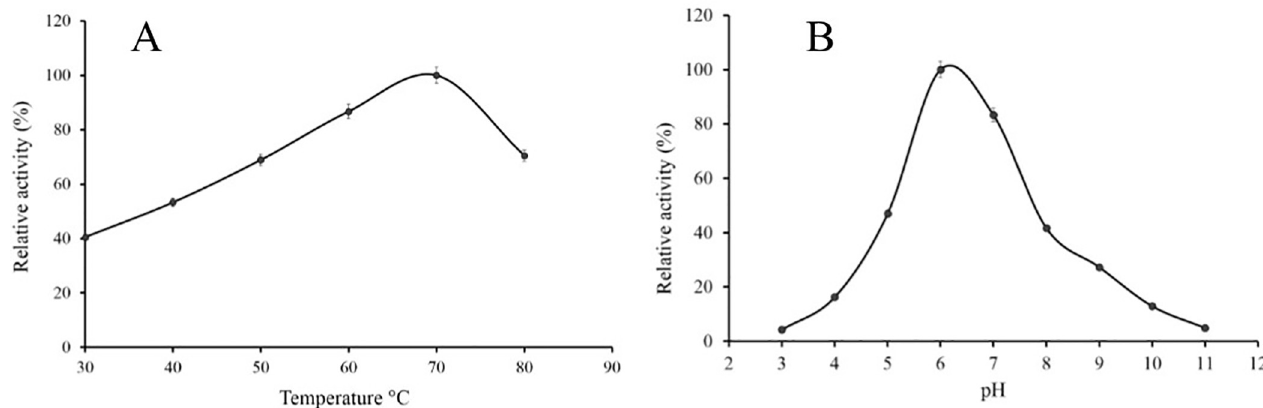
Fig 7. Effect of different pH and temperatures on the activity of the recombinant cholesterol oxidase. (A) Effect of temperature: enzyme activity was assayed in potassium phosphate 0.1 mM, pH 7.0 based on the formation of H 2 O 2 at the indicated temperatures. (B) Effect of pH: The residual activity was examined by monitoring H 2 O 2 generation at 25˚C. The buffer systems (0.1 M) utilized were glycine-HCl (pH 3.0), citrate-sodium citrate (pH 4.0),